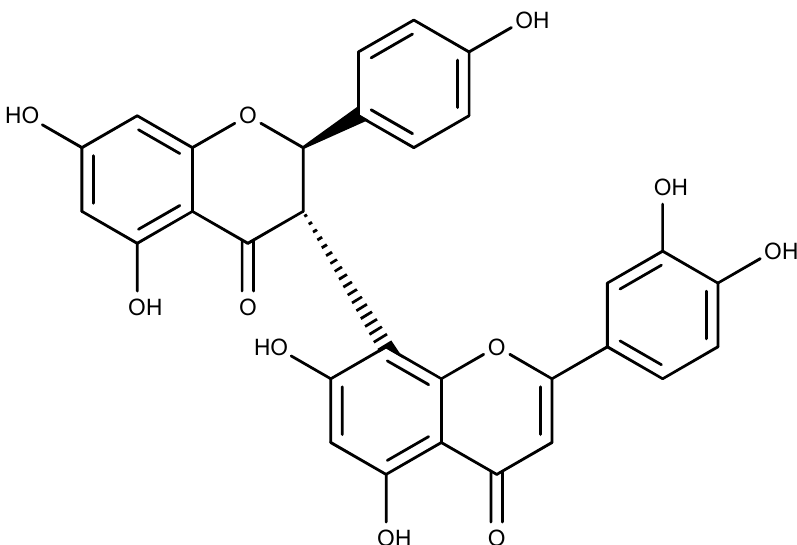
Figure 1. Chemical structure of (+)-morelloflavone [30].